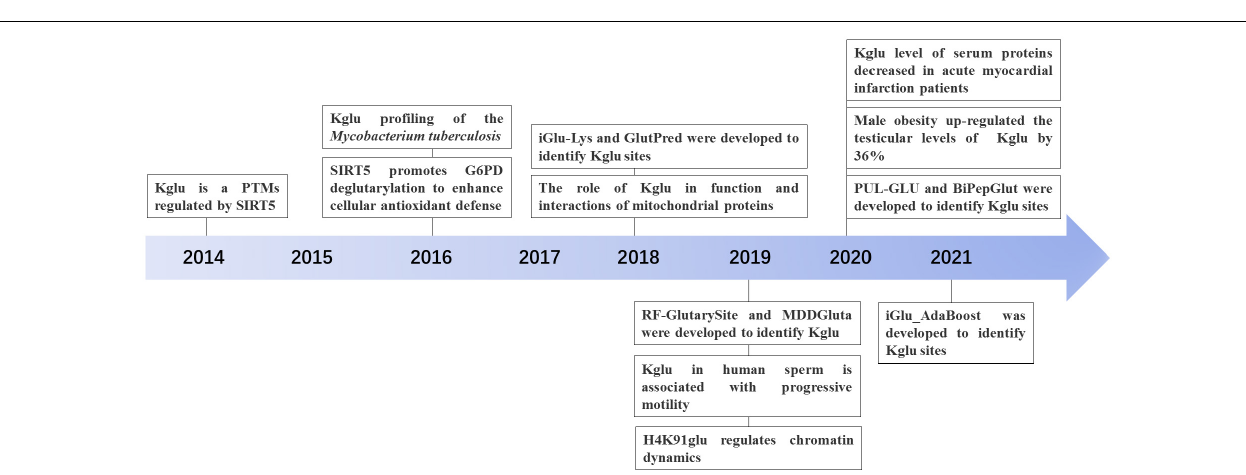
FIGURE 1 | The process of literature screening. The articles were sorted into three categories: mechanism, function, identification and prediction of glutarylated proteins. N = number of literature records.